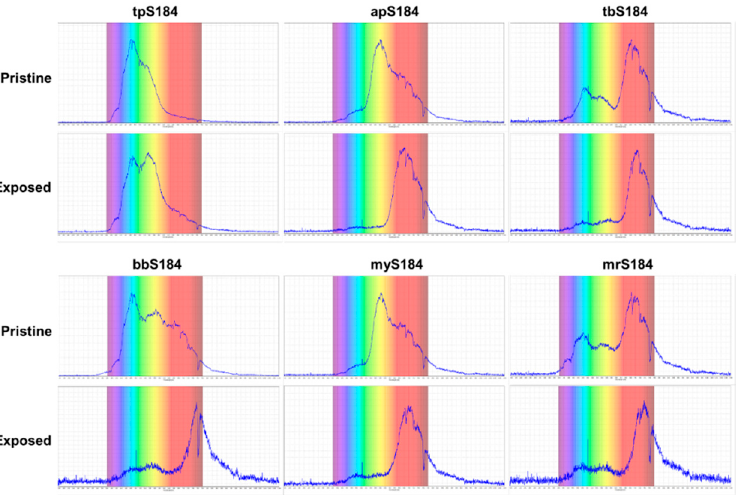
Figure 4. UV-Vis spectrophotometry data demonstrating the chromophoric behavior of the sensing devices.